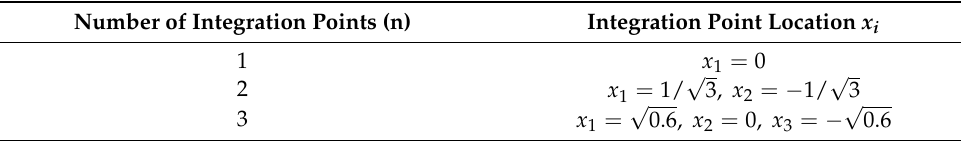
Table 1. Gauss numerical integration constants.